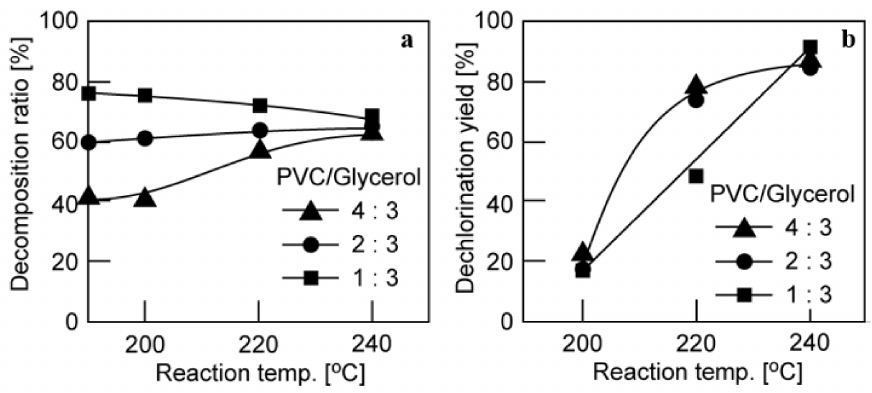
Figure 7. Effect of PVC/glycerol mass ratio on ( a ) decomposition ratio and ( b ) dechlorination yield.